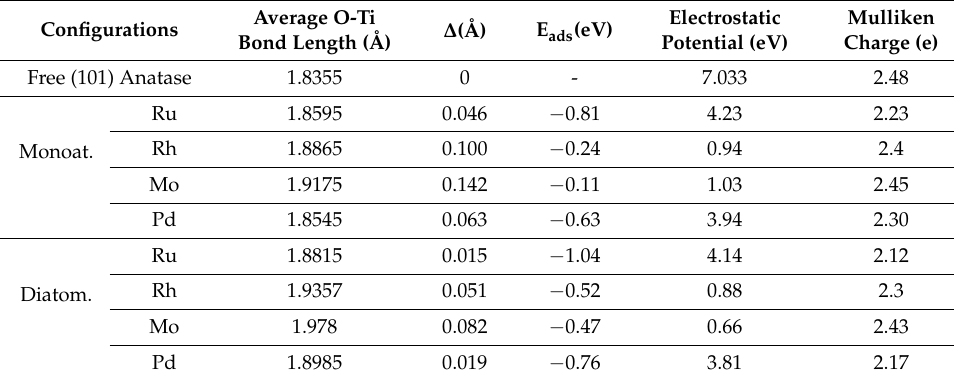
Table 2. Average O 2c -Ti 5c and O 2c -Ti 6c bond lengths (Å) adsorption-induced shift of average bond lengths (in Angstrom units), average electrostatic potentials and the Mulliken charges for the various M/(101)TiO 2 systems